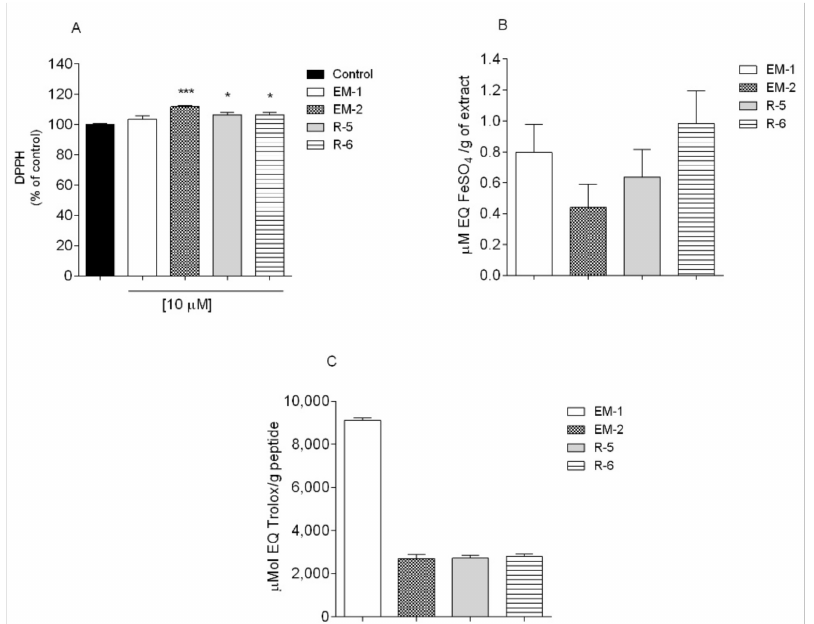
Figure 2. The antioxidant activity of the peptides evaluated through the DPPH ( A ), FRAP ( B ), and ORAC ( C ) methods. The values in each column represent the mean ± standard error of the mean (SEM) of 3 or 4 in-dependent experiments. Symbols represent significant differences (ANOVA, Dunett’s test, * p < 0.05, *** p < 0.001) when compared to: control. Neither endomorphins nor rubiscolins displayed the ability to reduce the DPPH